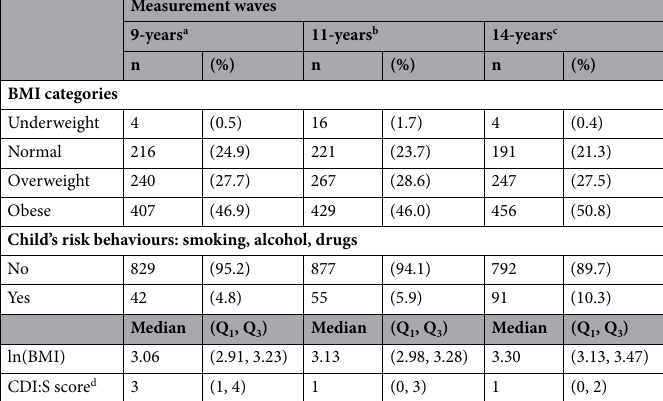
Table 2. Description of the child outcome data, by measurement waves. a BMI missing for 7 (0.8%), risk behaviours missing for 3 (0.3%), and CDI:S missing for 4 (0.5%) children; b BMI missing for 2 (0.2%), risk behaviours missing for 3 (0.3%), and CDI:S missing for 2 (0.2%) children; c BMI missing for 18 (2.0%), risk behaviours missing for 33 (3.6%), and CDI:S missing for 59 (6.4%) children; d CDI:S scores range from 0 to 20, with higher scores representing a greater level of